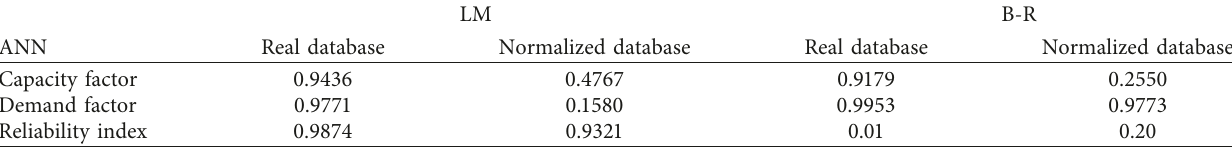
Table 5: ANN coefficient of determination, R